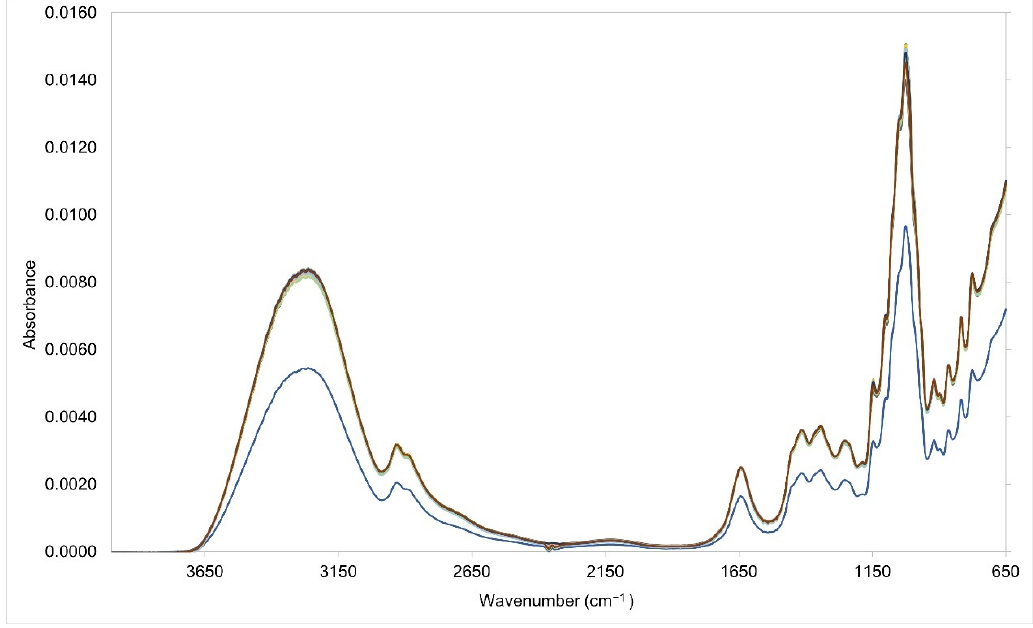
Figure 2. Vector normalized Fourier transform infrared spectra of the testing set.